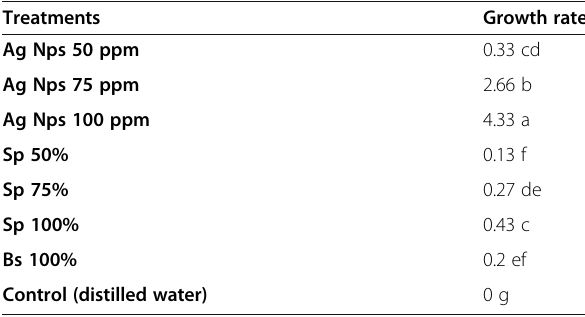
Table 2 Effect of Ag Nps ppm, Spirulina %, and Bacillus sp. on the growth rate culture of Pectobacterium carotovora